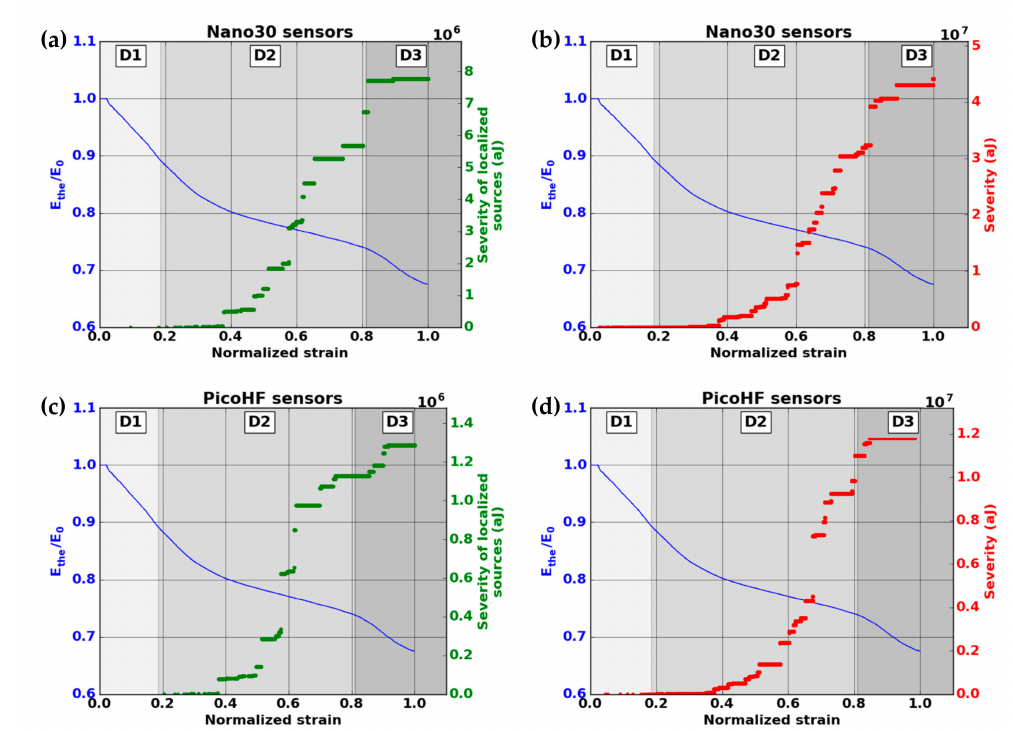
Figure 13. Evolution of the normalized elastic modulus and the severity versus strain during macroscopic tensile test in fiber orientation for ( a ) AE-localized signals by the Nano30 sensors, ( b ) for all the recorded signals by the Nano30 sensors, ( c ) AE-localized signals (PicoHF sensors) and ( d ) all the recorded signals (PicoHF